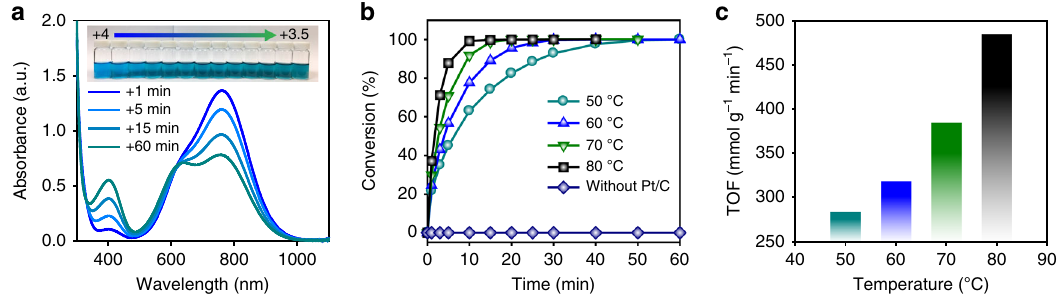
Fig. 2 Catalytic reduction of V 4 + to V 3.5 + . a Ultraviolet – visible (UV – Vis) spectra of the reactant electrolyte at different reaction times at 50 °C (inset: color changes of the reactant with the catalytic reaction). b Plots of the conversion with Pt/C at various reaction temperatures and that without Pt/C at 80 °C (100% conversion corresponds to the vanadium oxidation state of + 3.5). c TOF (turnover frequency, mmol of V 3 + (g of Pt) − 1 min − 1 ) of the catalytic reaction at different reaction temperatures